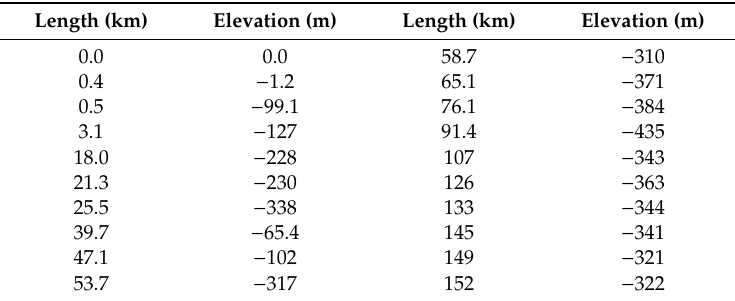
Table 6. Elevation Profile Used in the